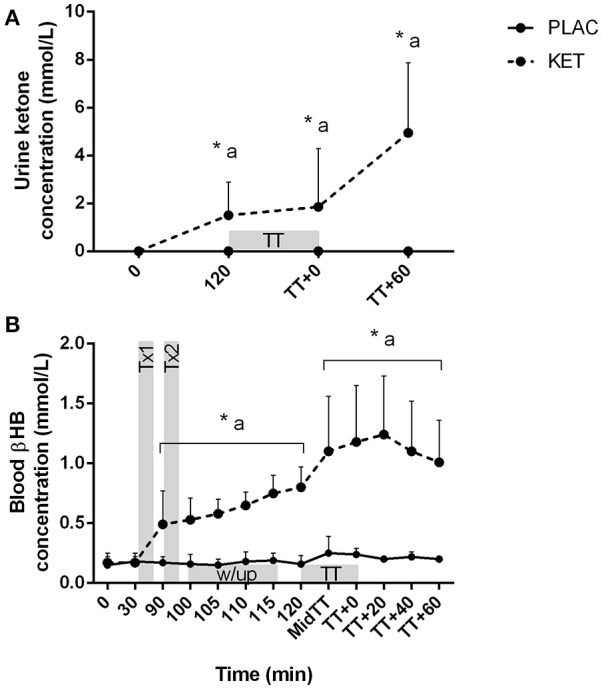
Urine ketone (A) and blood βHB (B) concentrations following exogenous KET or PLAC ingestion whilst completing a cycling TT. Values are mean ± SD. Tx1 and Tx2 refer to dose one and two of KET or PLAC drink, w/up refers to warm-up. *KET different to PLC at time point; a different to t = 0 min within KET.